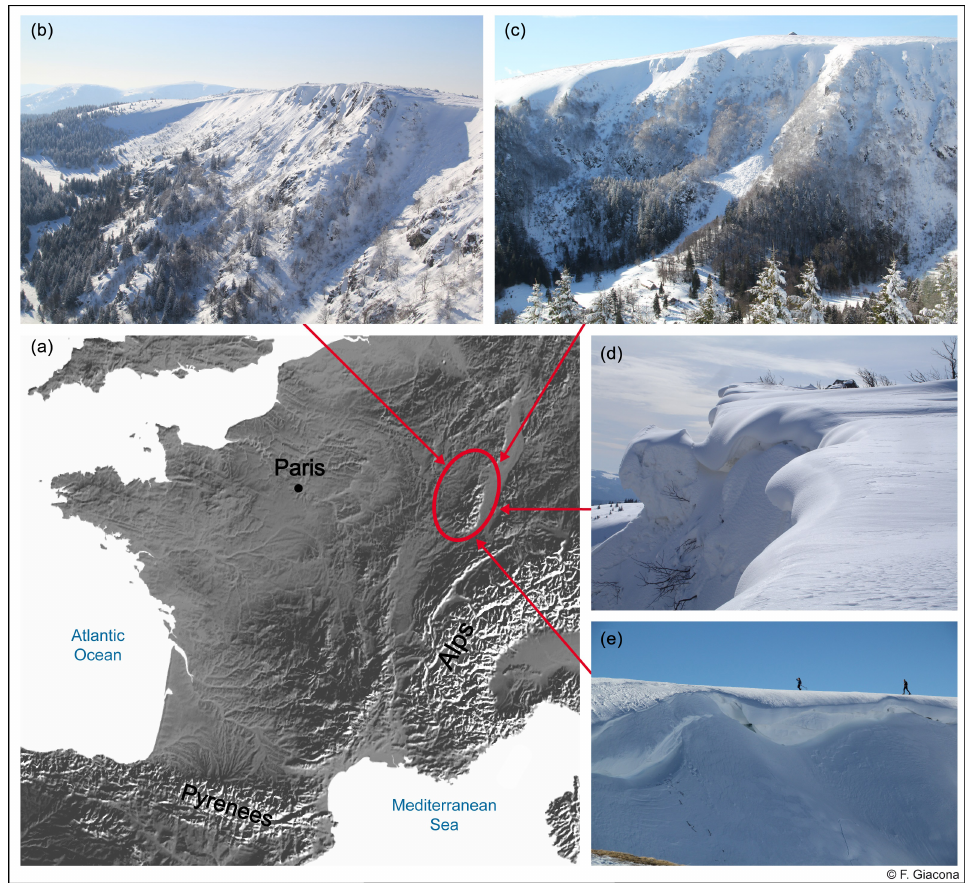
Figure 1. Location of the Vosges Mountains in the north-east of France ( a , red circle). Avalanches occur mainly in former glacial cirques (b, c) . At the top of these, huge cornices often develop during the winter season (d, e) , and their fracture is the most common avalanche-triggering